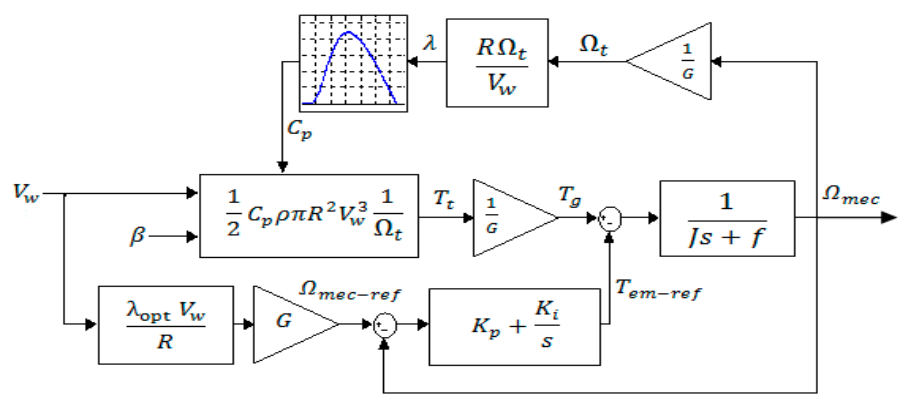
Figure 2. Wind turbine model with speed control.